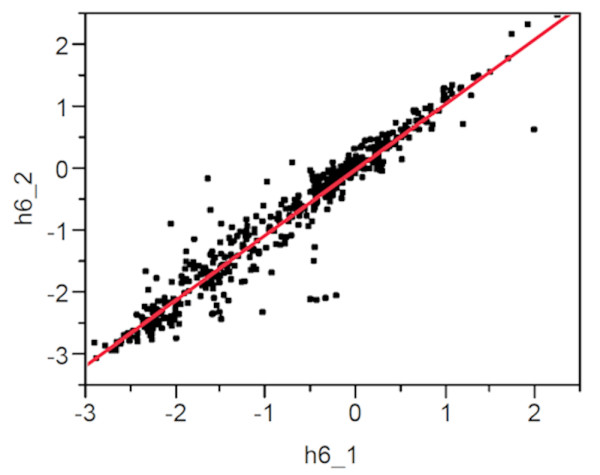
Scatter plot analysis of the M-values from two microarray hybridizations using RNA samples from two independent kumquat plants inoculated with 5 × 108 cfu/ml Xcc. Each spot represents the normalized hybridization signal intensity for each transcript on the microarray. RNA samples from non-inoculated and inoculated leaf tissue were labeled with Cy3 and Cy5, respectively. (h6_1): 6 hours post inoculation hybridization results from slide # 1 hybridized to plant A-RNA samples vs. (h6_2): 6 hours post inoculation hybridization results from slide # 2 hybridized to plant B-RNA samples.